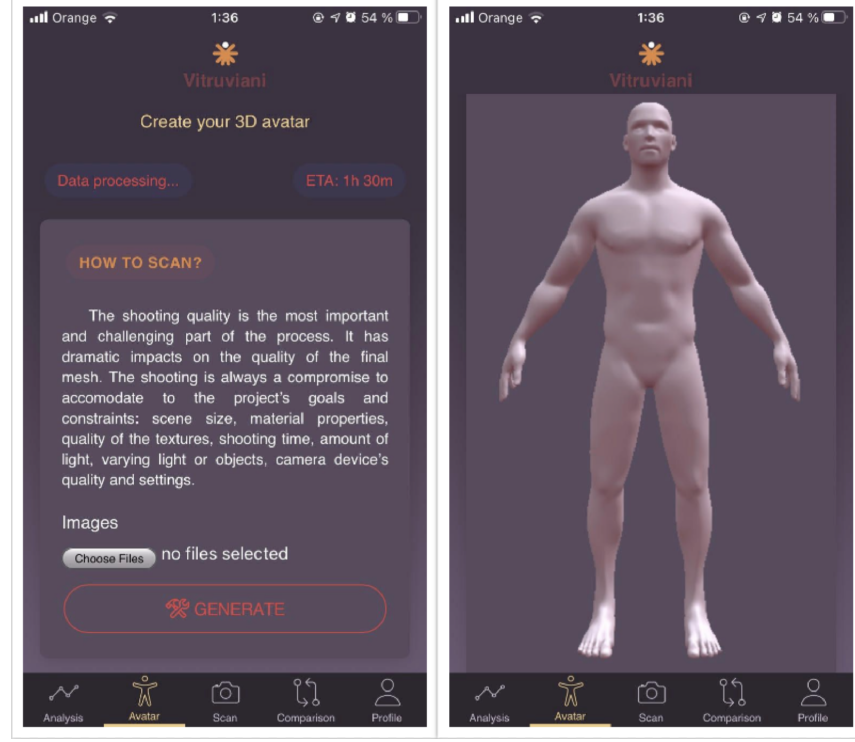
Figure 7. Avatar page with process of generating vs. viewing